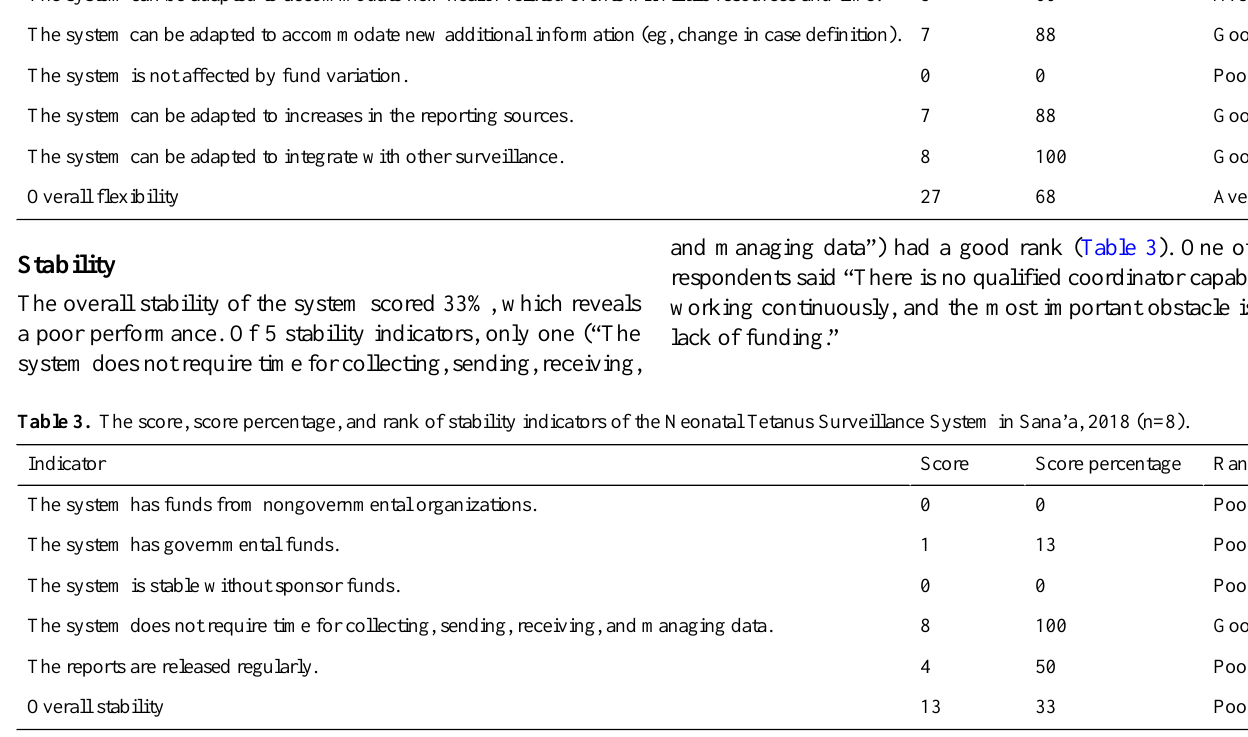
Table 4. The score, score percentage, and rank of simplicity indicators of the Neonatal Tetanus Surveillance System in Sana’a, 2018 (n=26).